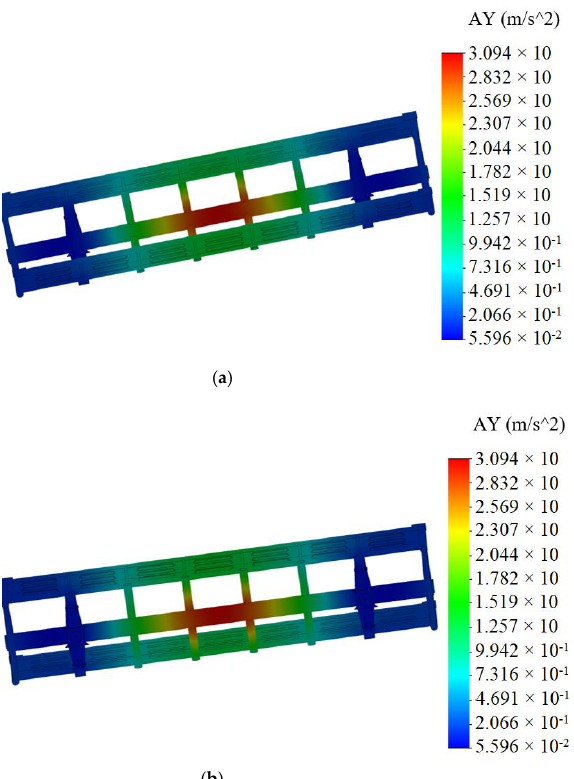
Figure 9. Acceleration distribution fields relative to carrying structure of circular tube open wagon ( a ) top view; ( b ) bottom view.